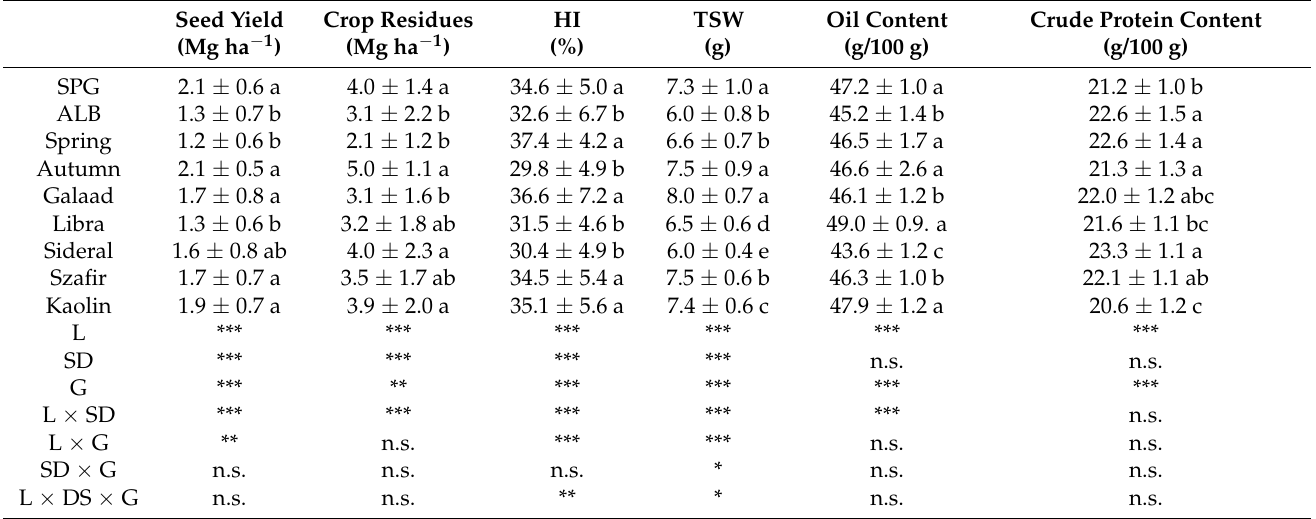
Table 4. Main effects of location (L), sowing date (SD) and genotype (G) and their interaction on linseed seed yield, vegetative biomass, harvest index (HI), thousand seed weight (TSW), oil and protein concentrations. Data refer to mean values ± standard deviation.